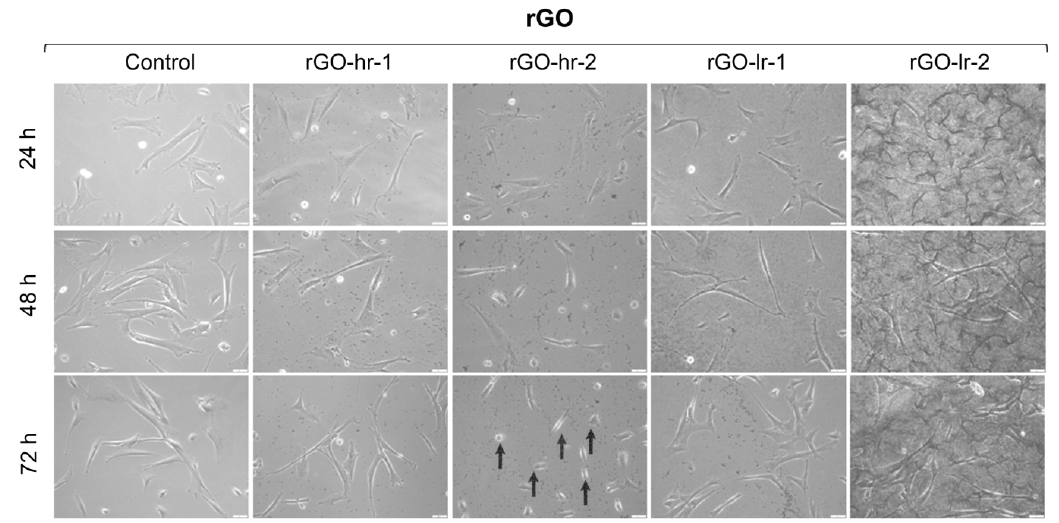
Figure 4. Morphology of the human Wharton’s jelly umbilical cord-derived mesenchymal stem / stromal cells (hUC-MSCs) cultured on the GO and rGO surfaces after 24, 48, and 72 h of culture. Representative images are presented; magnification: 100 × . The arrows indicate morphological changes of the hUC-MSCs. Legend: GO-sf-1: small flakes / thick layer; GO-sf-2: small flakes / thin layer; GO-lf-1: large flakes / thick layer; GO-lf-2: large flakes / thin layer; rGO-hr-1: high reduction level / thin layer; rGO-hr-2: high reduction level / thick layer; rGO-lr-1: low reduction level / thin layer; rGO-lr-2: low reduction level / thick layer; Control: tissue culture plastic surface (TCPS).